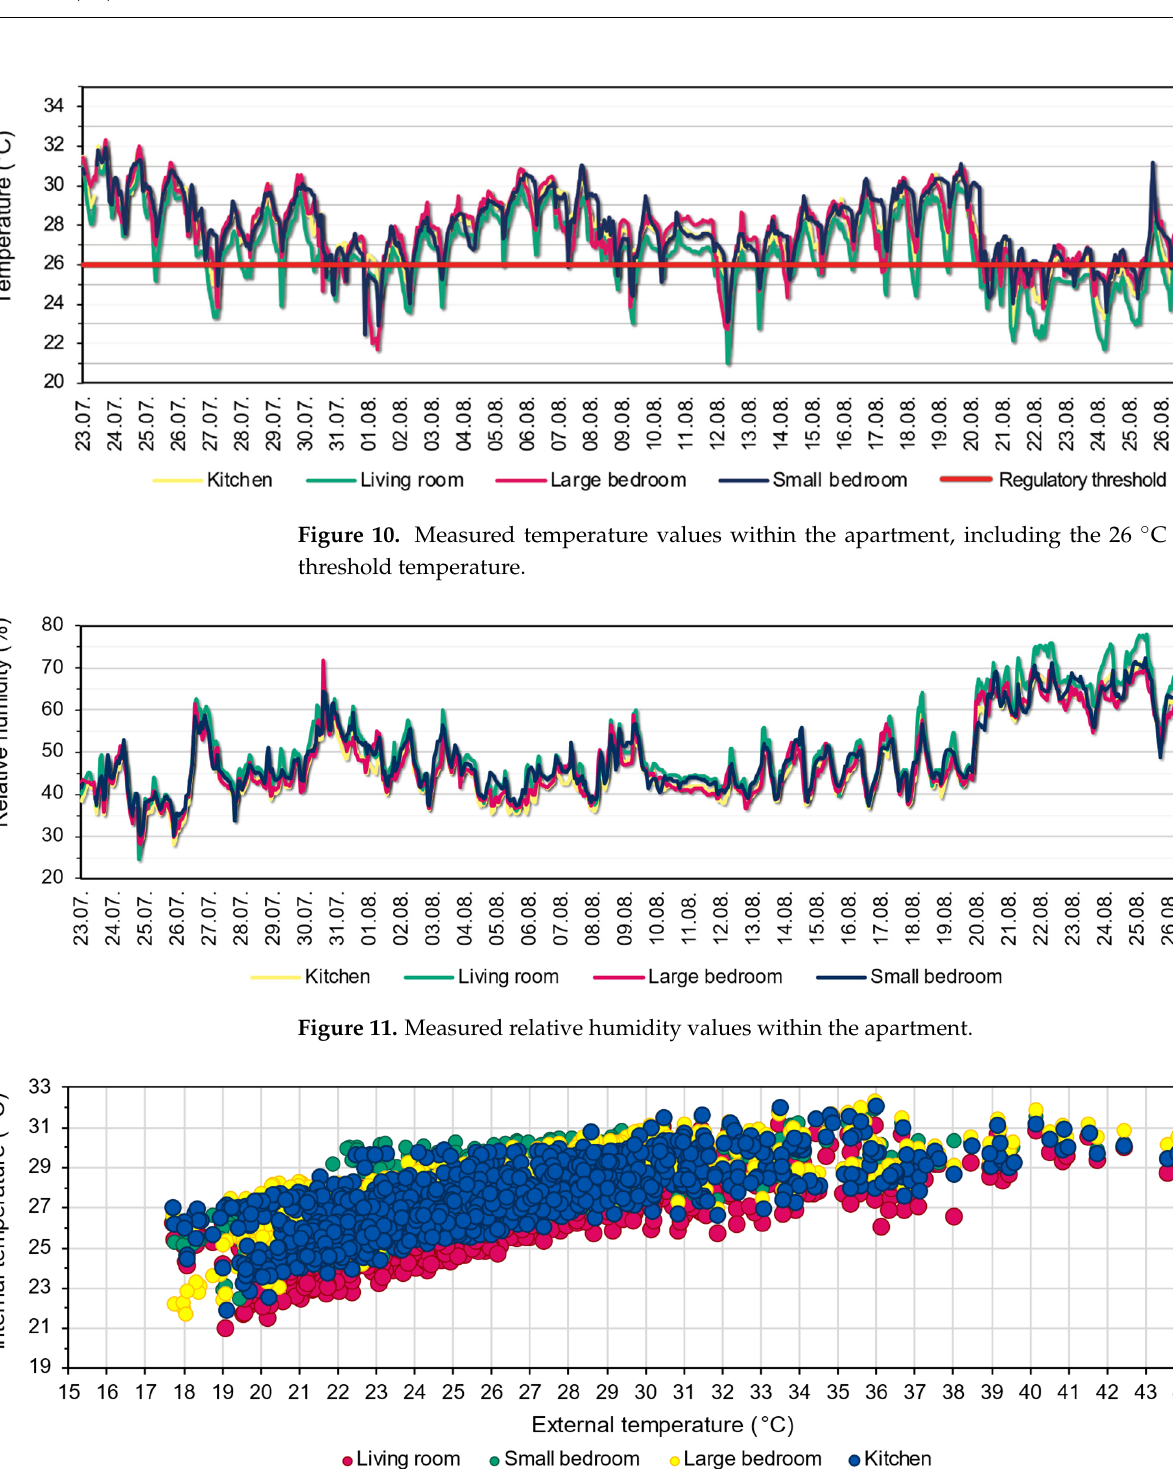
Table 1. Statistics of the measured temperature and relative humidity (K—kitchen, LR—living room, SB—small bedroom, LB—large bedroom, E—external balcony). Figure 12. Internal room temperatures as the function of the external temperature within the measurement period.